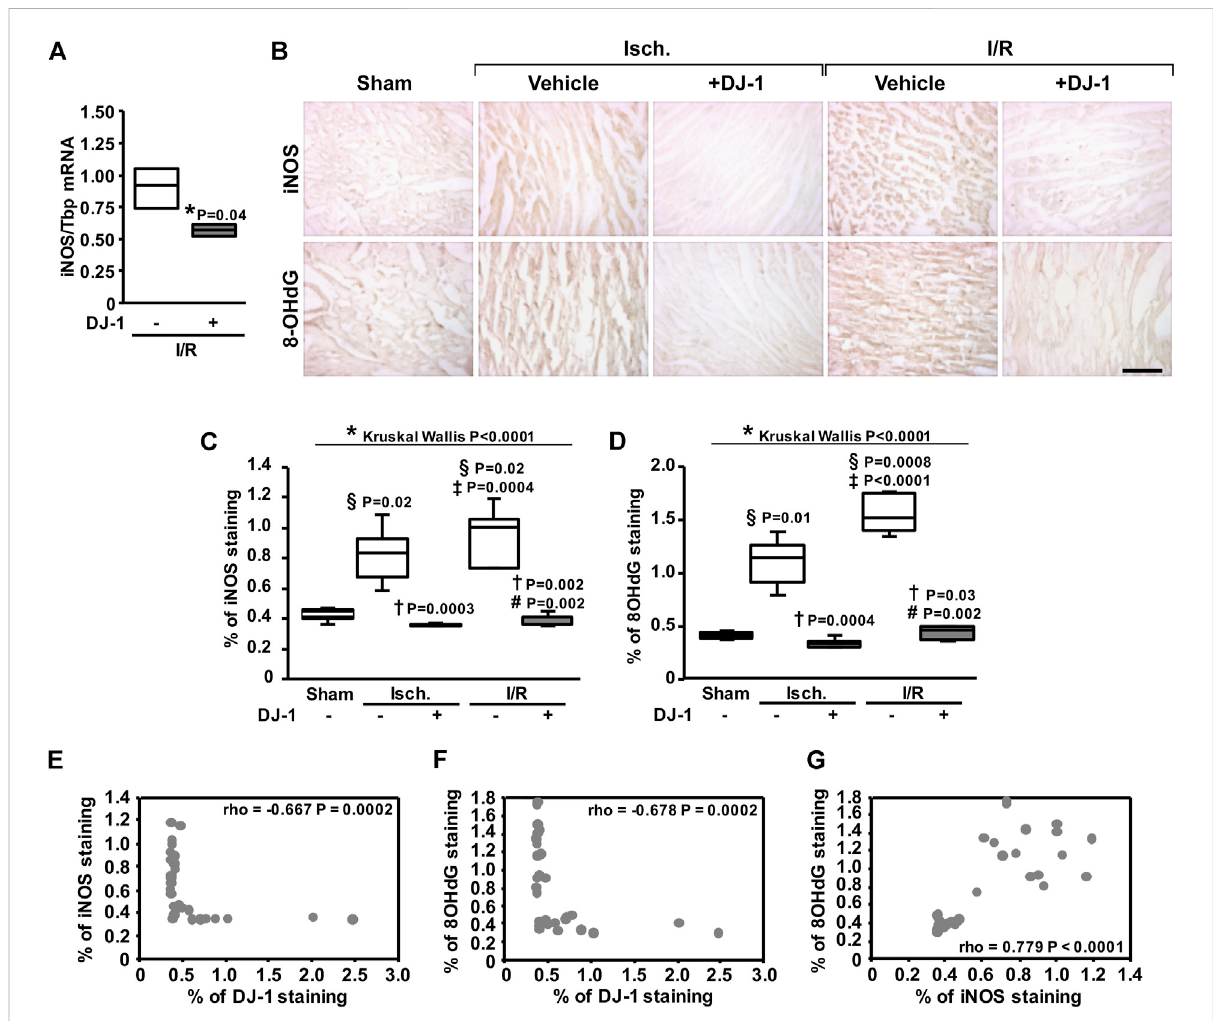
Systemic DJ-1 administration effects on oxidative stress after ischemia and ischemia/reperfusion. (A) Inos transcript analysis by qPCR. (B) Representative immunohistochemical acquisitions of myocardial iNOS (upper panel) and 8-OHdG (lower panel) after ischemia and ischemia/ reperfusion in the presence and the absence of a systemic administration of DJ-1. A sham-operated group was included as baseline. (C) Myocardial iNOS content quanti fi cation. (D) Myocardial 8-OHdG content quanti fi cation. (E – G) Correlation analyses between iNOS and DJ-1 (E) , 8-OHdG and DJ-1 (F) , and iNOS and 8-OHdG (G) staining signals. Scale bar: 100 µm; * p < 0.05, Kruskal-Wallis; § p < 0.05 vs. sham, † p < 0.05 vs. ischemia withoutDJ-1, ‡ p < 0.05vs.ischemia+DJ-1,# p < 0.05vs.I/RwithoutDJ-1,Dunn ’ stest;rho,Spearmanrankcorrelationcoef fi cient.Isch.,Ischemia;I/ R,